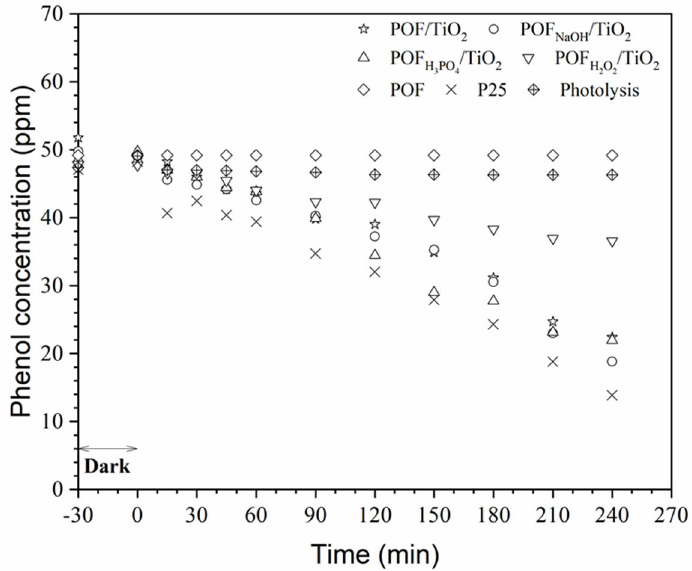
Figure 6. Effect of chemical pre-treatment ([Phenol] 0 = 50 mg/L; m POF/TiO2 = 50 mg; c POF/TiO2 = 1 g/L, m P25 = 50 mg, c P25 = 1 g/L, λ = 254 nm; V phenol = 50 mL; pH = 6.7).